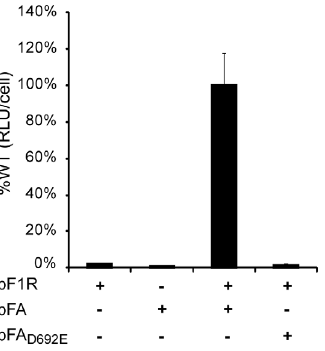
Figure 2. Validation of FHV replication-dependent luciferase expression. Yeasts transformed with the indicated plasmids were assayed for luciferase activity. As shown, significant luciferase activity was only observed when there is active FHV RNA replication and subgenomic mRNA synthesis, which depend on expressing both functional protein A (expressed from pFA) and a functional FHV RNA1 derived template RNA (from pF1R). Neither protein A (pFA) alone, nor the RNA1 derived template RNA (pF1R) alone produced luciferase activity above background. The need for FHV RNA synthesis is further demonstrated by the effects of a polymerase-inactivating mutation in the protein A active site (expressed from pFA(GED)), which reduces luciferase activity to background level even when expressed together with pF1R.